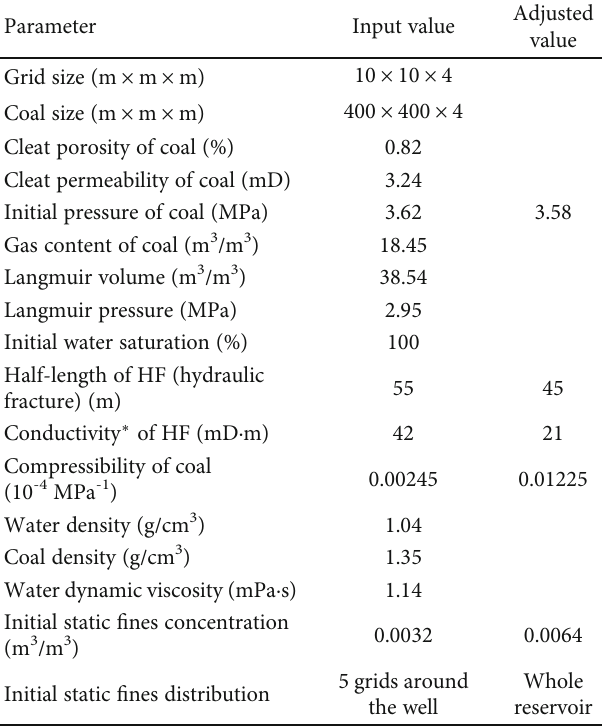
Table 4: Input and adjusted parameters in the simulation of the well ZY-n.